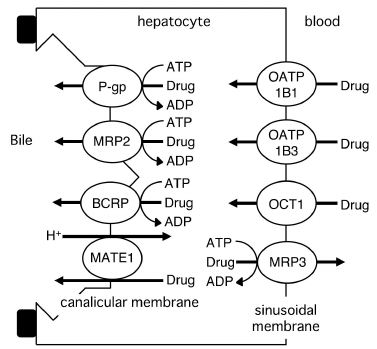
Figure 3. Drug transporters in the